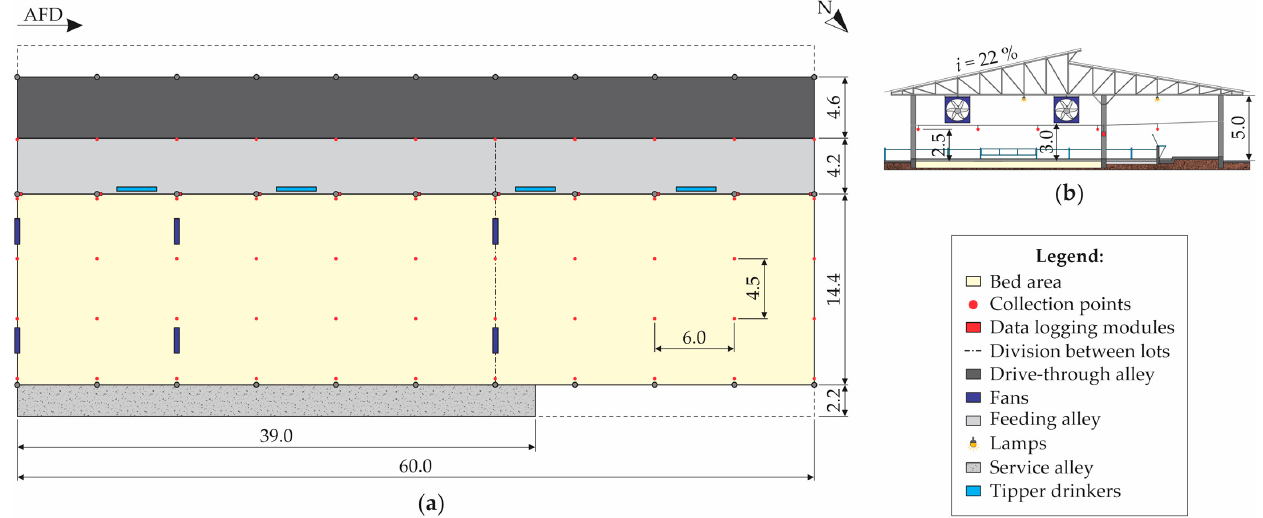
Figure 1. Schematic representation, in ( a ) low plan and ( b ) cross-sectional views, of the compost- bedded pack barn system, with data collection points indicated. AFD—air-flow direction; N—north indication; i —roof pitch; dimensions in meters (m).